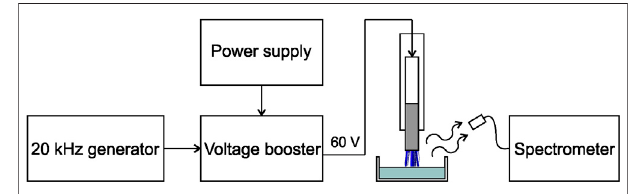
FIGURE 1 | Emission spectrum measurements setup.